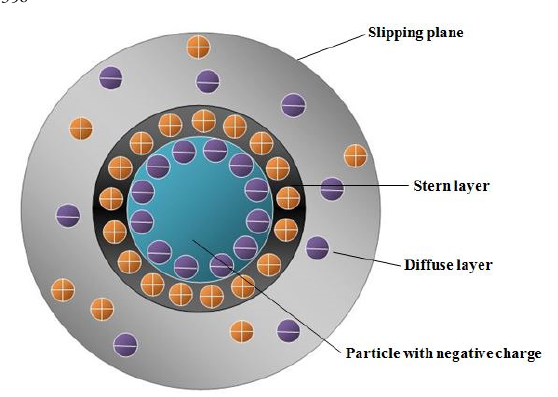
Fig. 12. FTIR sperta of G. applanatum extract mediated silver nanoparticles